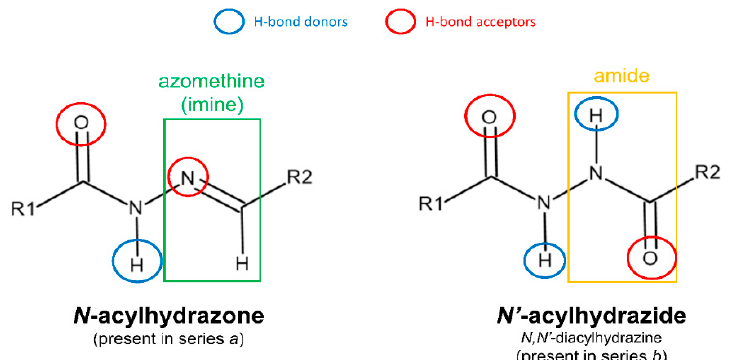
Figure 1. Comparison of N -acylhydrazone and N’ -acylhydrazide structural motifs.